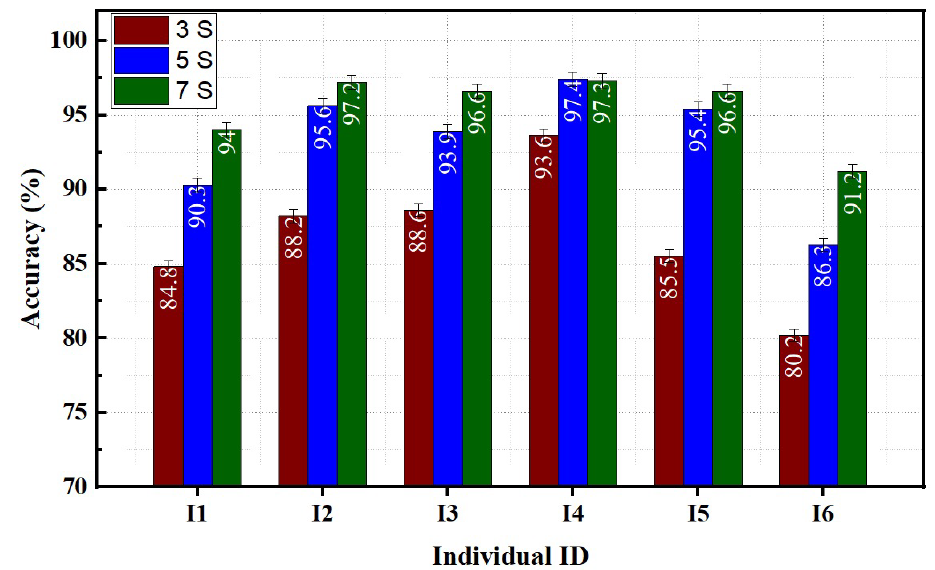
Figure 6. Effect of sensor’s quantity on individual performance.